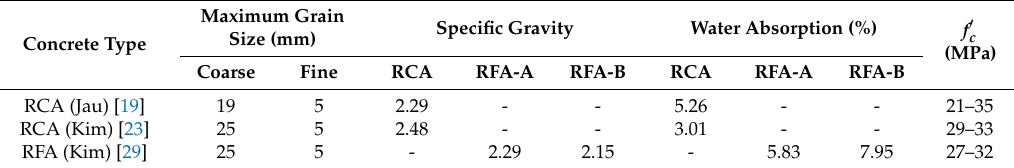
Table 7. Physical properties of recycled aggregate and RAC in other studies.